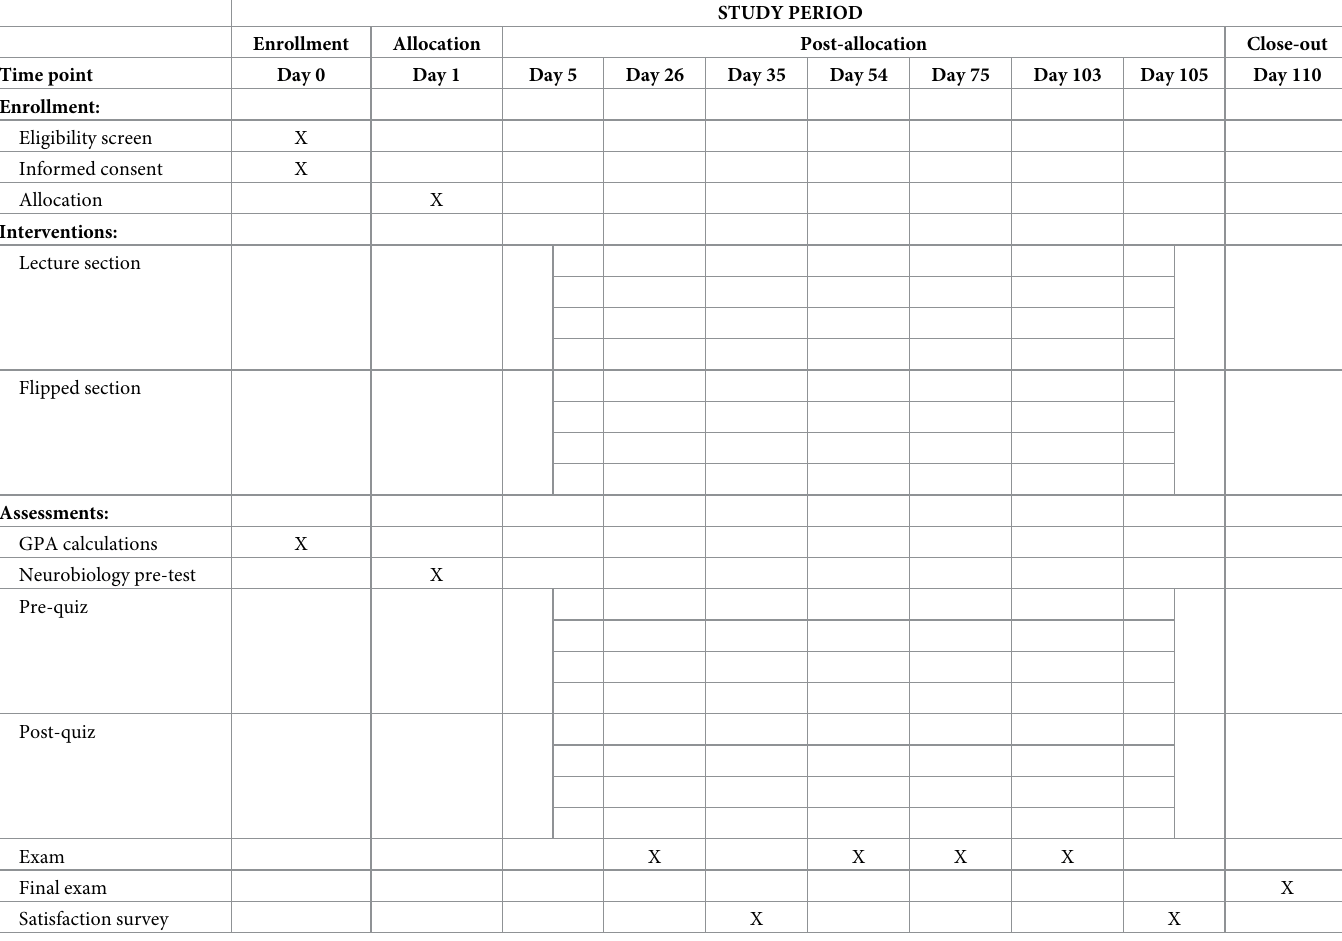
Table 1. Standard Protocol Items: Recommendations for Interventional Trials (SPIRIT) checklist for Study